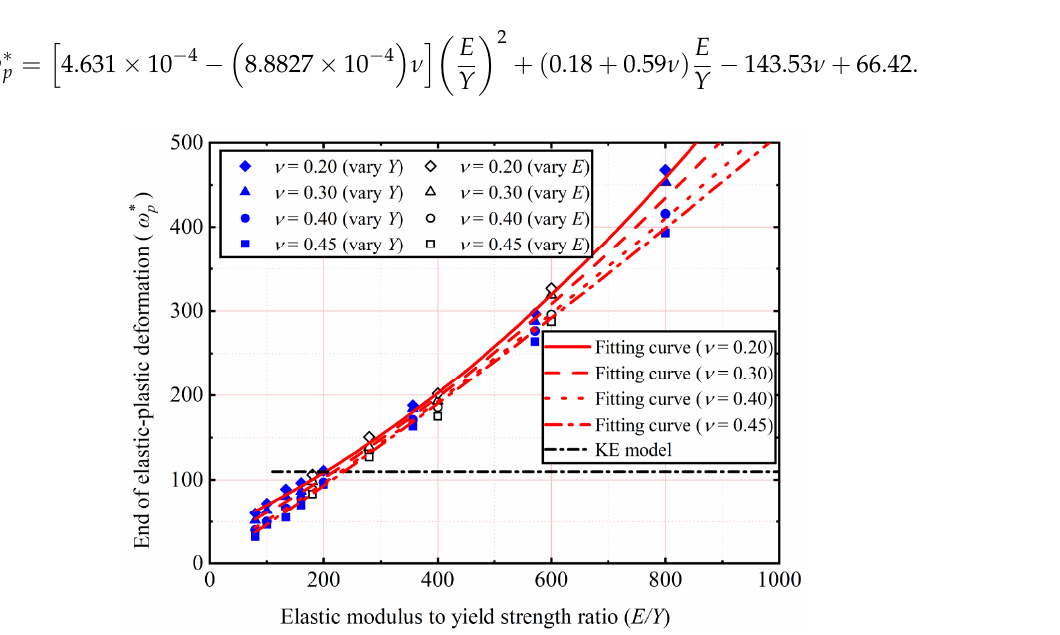
Figure 12. ω ∗ p as a function of E / Y . *  as a function of E/Y . Figure 12. p